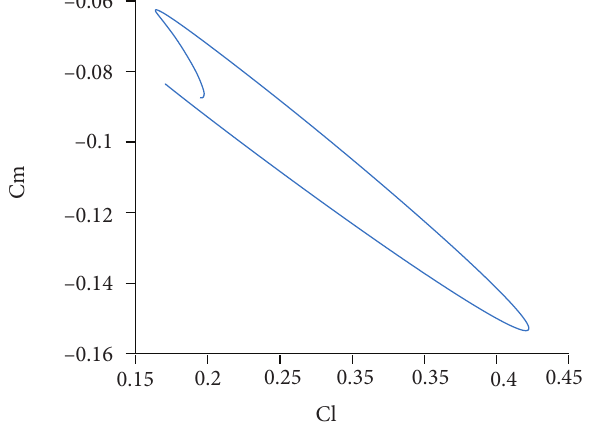
Figure 10. Response curve of pitching moment coefficient of the UAV with lift coefficient under 1-cos gusts.